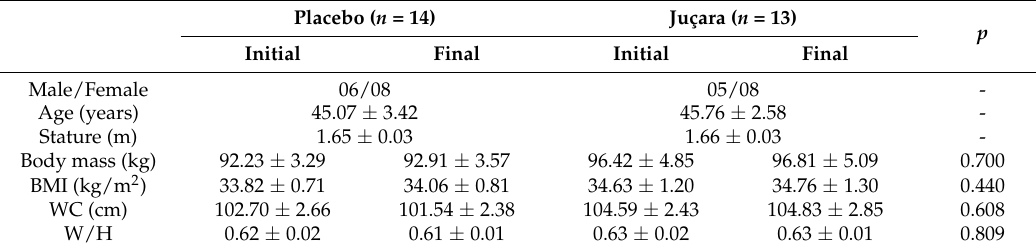
Table 4. Sample descriptive